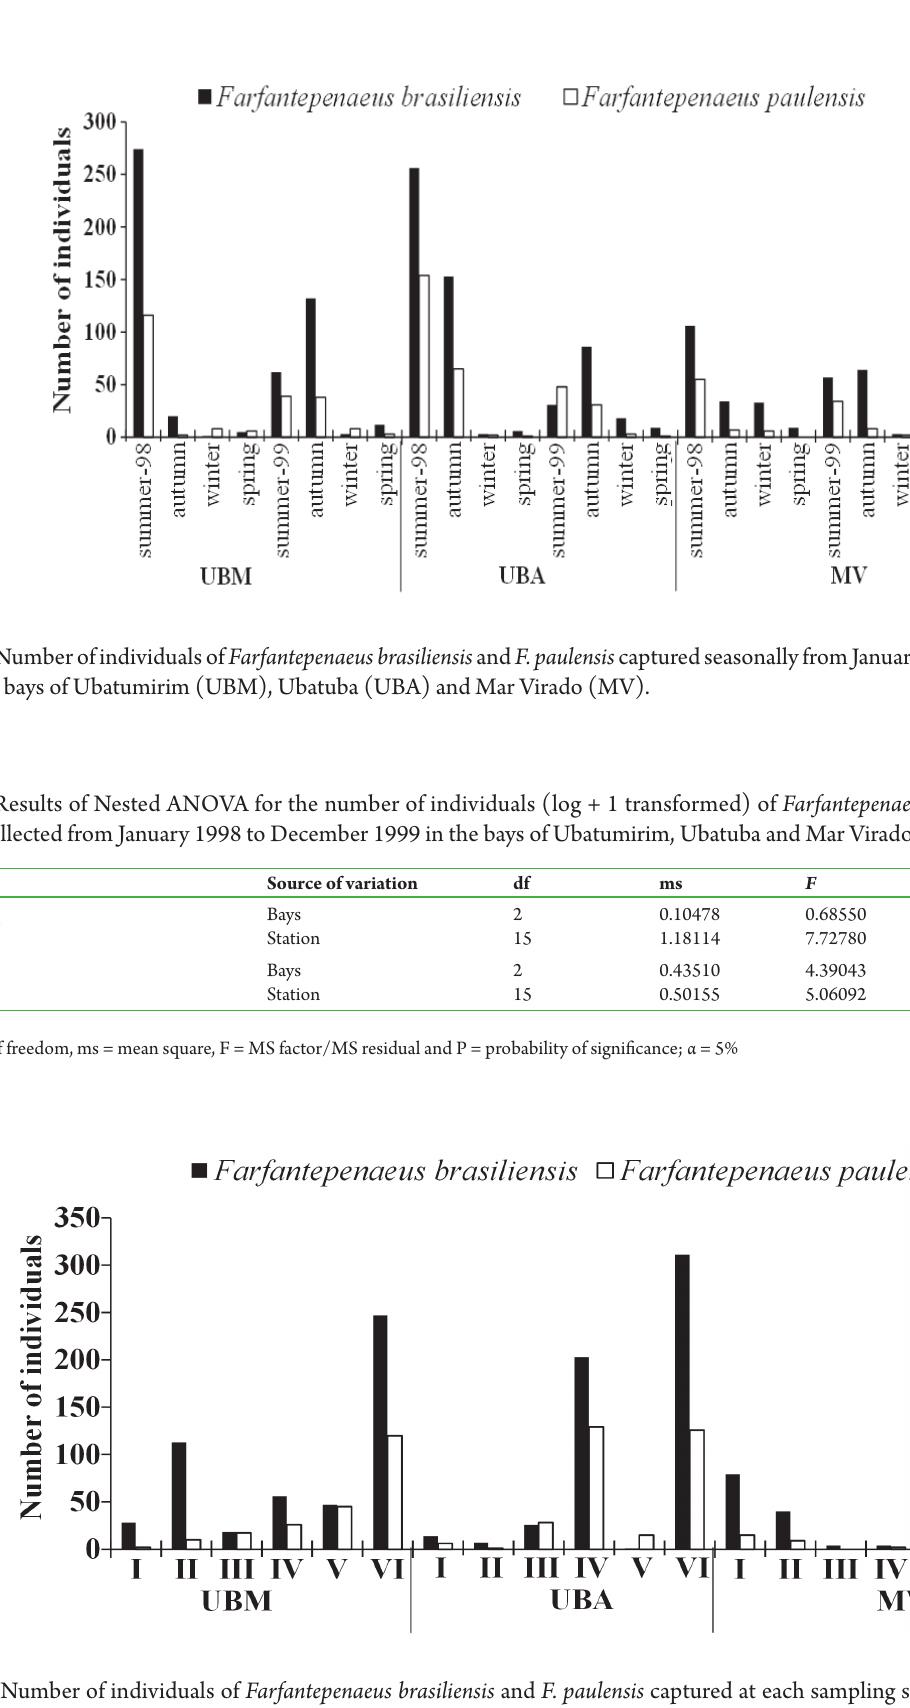
Figure 6. Number of individuals of Farfantepenaeus brasiliensis and F. paulensis captured at each sampling station in the bays of Ubatumirim (UBM), Ubatuba (UBA) and Mar Virado (MV), from January 1998 to December